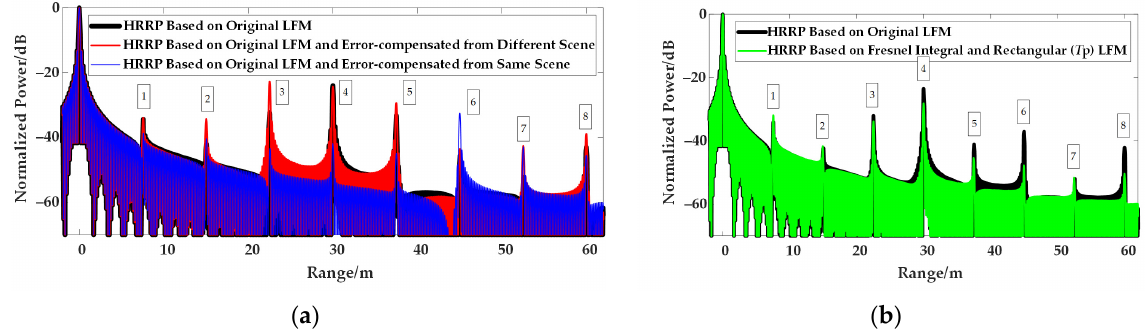
Figure 17. HRRPs based on the measured LFM subpulse with a stepped frequency of 20 MHz: ( a ) HRRP based on original LFM subpulse and error-compensated HRRP based on original LFM subpulse from the same/different scene; ( b ) HRRPs based on original LFM subpulse and Fresnel integral and rectangular windowed LFM subpulse.